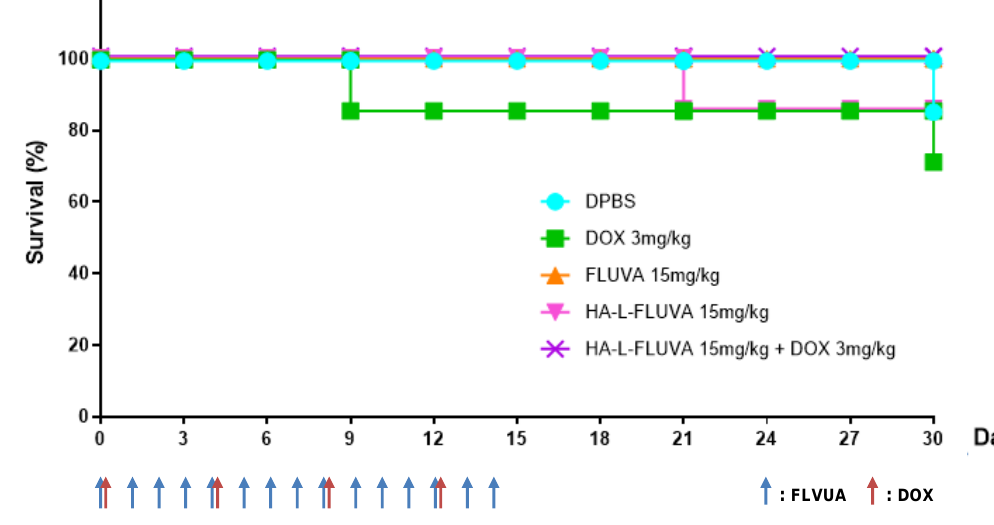
Figure 5. Kaplan–Meier plot showing the 30-day survival rate of a xenograft mouse model treated with DPBS, DOX, FLUVA, HA-L-FLUVA, and HA-L-FLUVA + DOX.